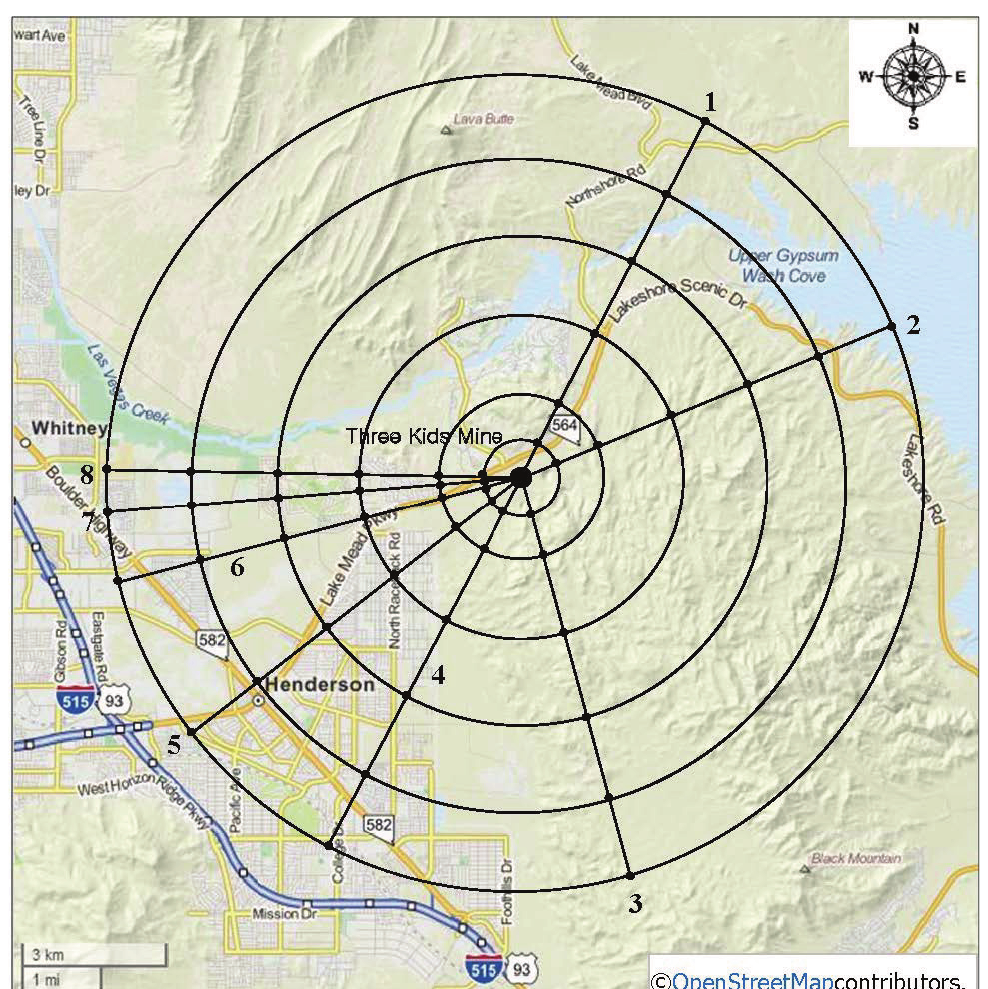
Figure 2. Sampling Locations on eight transects at 0.8 km, 1.6 km, 3.2 km, 4.8 km, 6.4 km, and 8.0 km around the middle point of the Three Kids Mine tailings ponds. Google